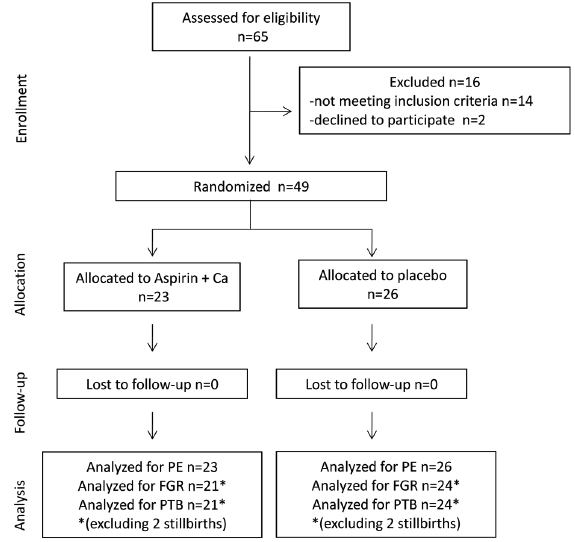
Figure 1. Flow diagram of the randomized trial on supplementa- tion with aspirin plus calcium for preventing superimposed preeclampsia in high-risk women at 20-27 weeks gestation, in Sa˜ o Paulo, Brazil. Ca: calcium; FGR: fetal growth restriction; PE: preeclampsia; PTB: preterm birth.